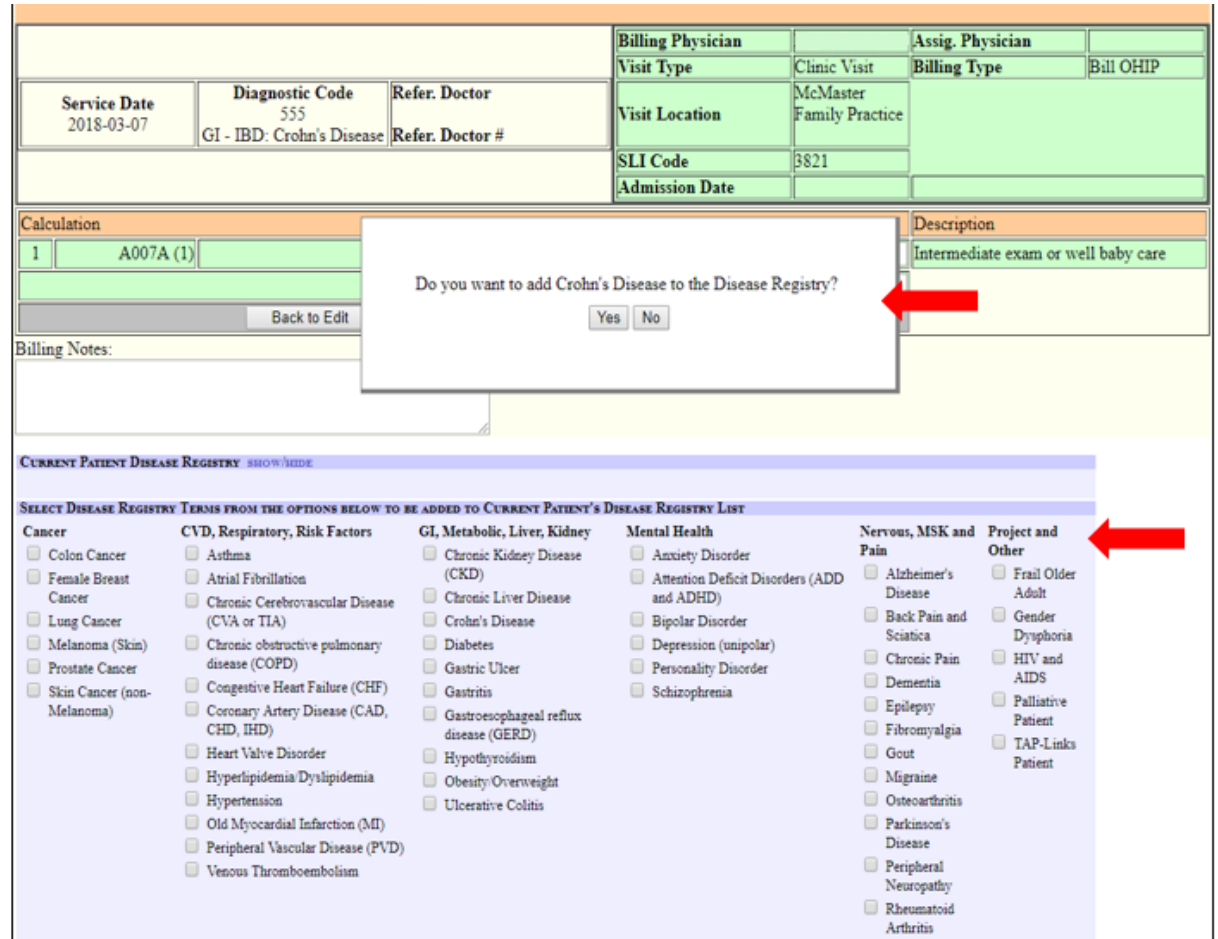
Figure 1. The quick-pick list for disease registry data entry with a pop-up prompt embedded within the billing